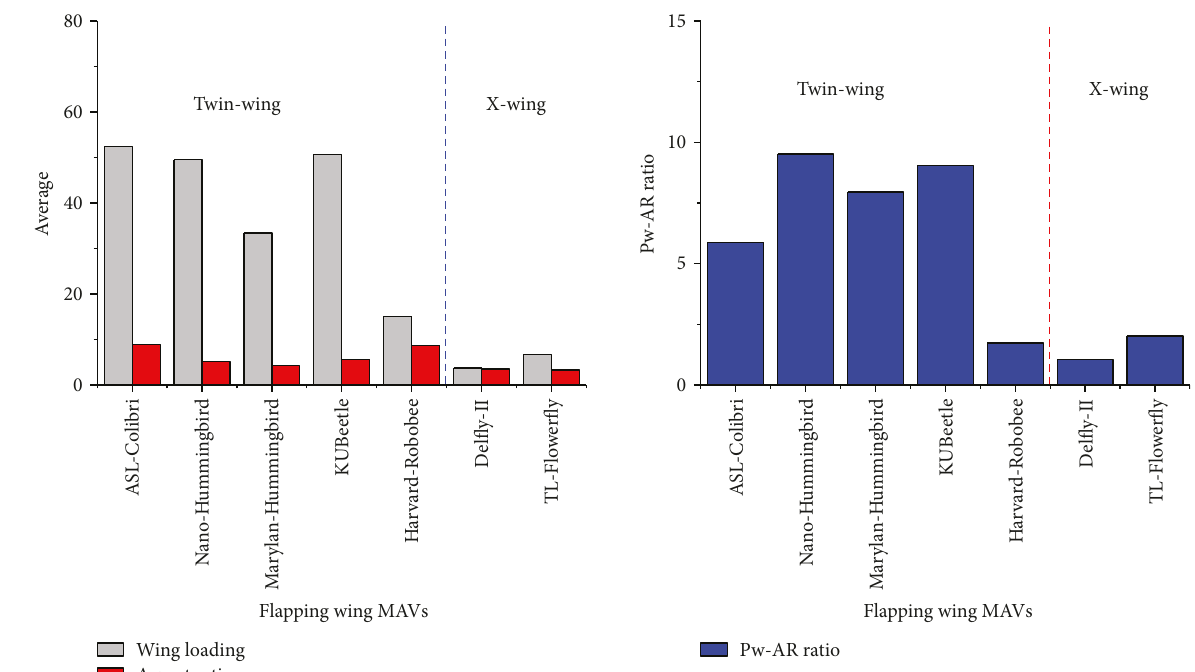
− AR ratio (right). w